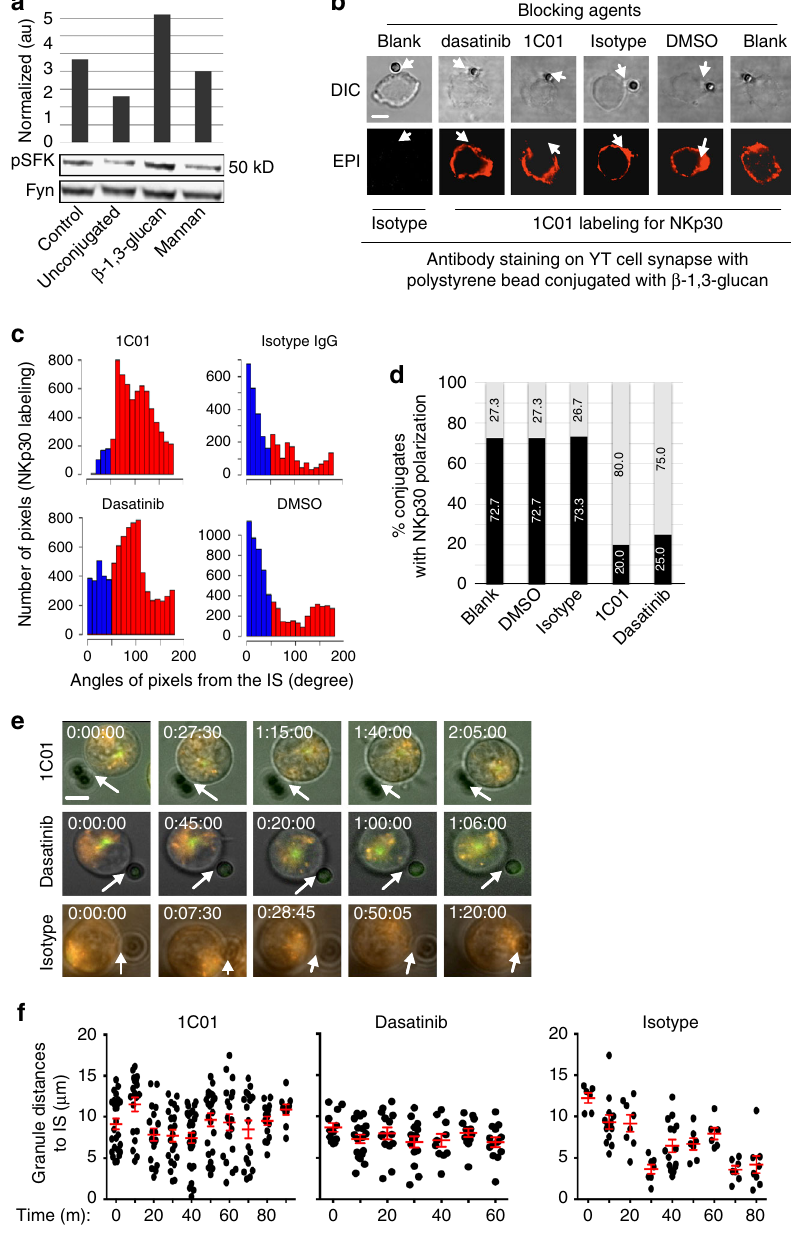
Fig. 6 β -1,3-glucan induces SFK signaling in NK cell response. a Western blot analysis of SFK phosphorylation in YT cells in response to β -1,3-GB vs. controls. The experiment was done twice with similar results. pSFK phosphorylated SFK (Src Family Kinase, Y416), control YT cells alone. b NKp30 expression in YT cells in response to β -1,3-GB in the presence of 12.5 μ g/ml of 1C01, 50 nM dasatinib, or controls (isotype IgG or DMSO). Cells and beads were labeled with 1C01. Arrow indicates interface between the YT cell and beads. The experiment was repeated at least three times on different days with similar results. Bar = 5 µ m. c Proximity of NKp30 expression in relation to the radius de fi ned by the IS (representative of n = 15 cells analyzed for 1C01 or 20 cells for dasatinib) in panel b . Clustering was de fi ned when the peak of fl uorescence was at an angle less than 45° (blue bars in the left). d Frequency of NKp30 clustering in YT cell that had formed conjugates with beads in panel b as de fi ned in panel c . e Representative photomicrographs derived from time- lapse videos of YT cells in response to polystyrene beads conjugated with β -1,3-glucan in the presence or absence of 1C01 or dasatnib (Supplementary movies 4 – 7), respectively. YT cells were loaded with Lysotracker and incubated with 1C01, dasatinib, or control medium before being incubated with β -1,3- GB. The experiment was performed for three times with similar results. Bar = 5 µ m. f Distances from each granule to the IS derived from data as in panel a (red symbols indicate mean ±